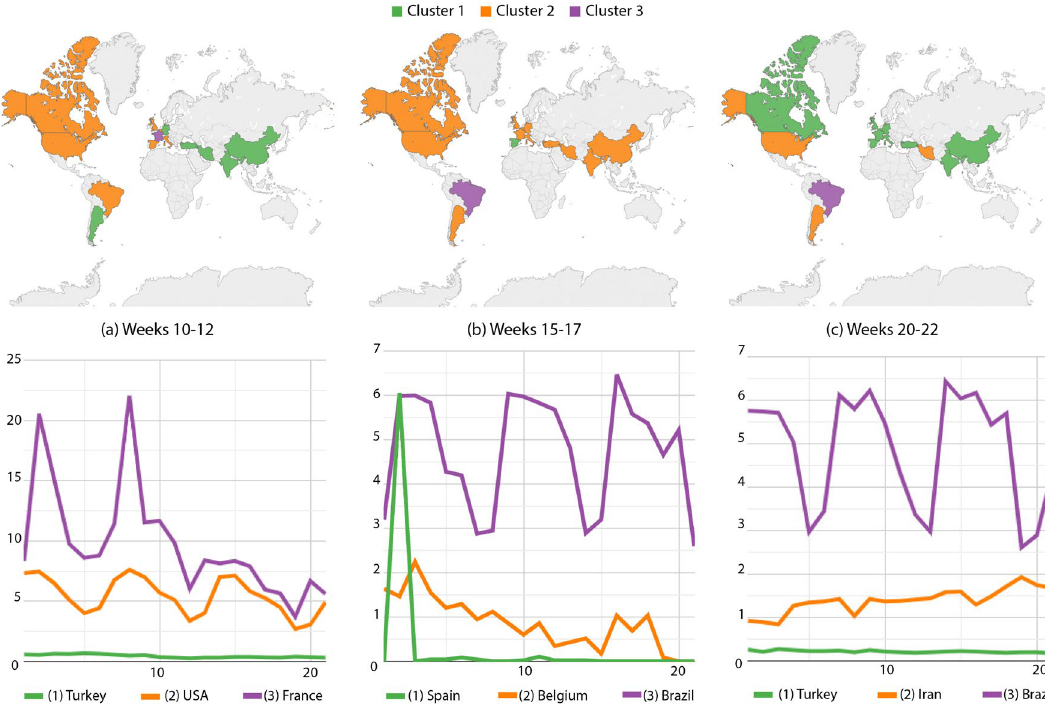
Figure 7. Death cases per million inhabitants: country partitions along weeks 10–22. Top images identify country groups and bottom curves correspond to the infection incidence levels: green, orange and purple correspondingly map the low, medium and high-incidence groups. Curve legends indicate the group descriptor. Top-most maps were generated by using Tableau Desktop-Professional Edition (https:// www. table au. com/, version 20181.20.0213.2110-64 bit), and bottom-most charts were generated by using Google Charts (https:// devel opers. google. com/ chart, version